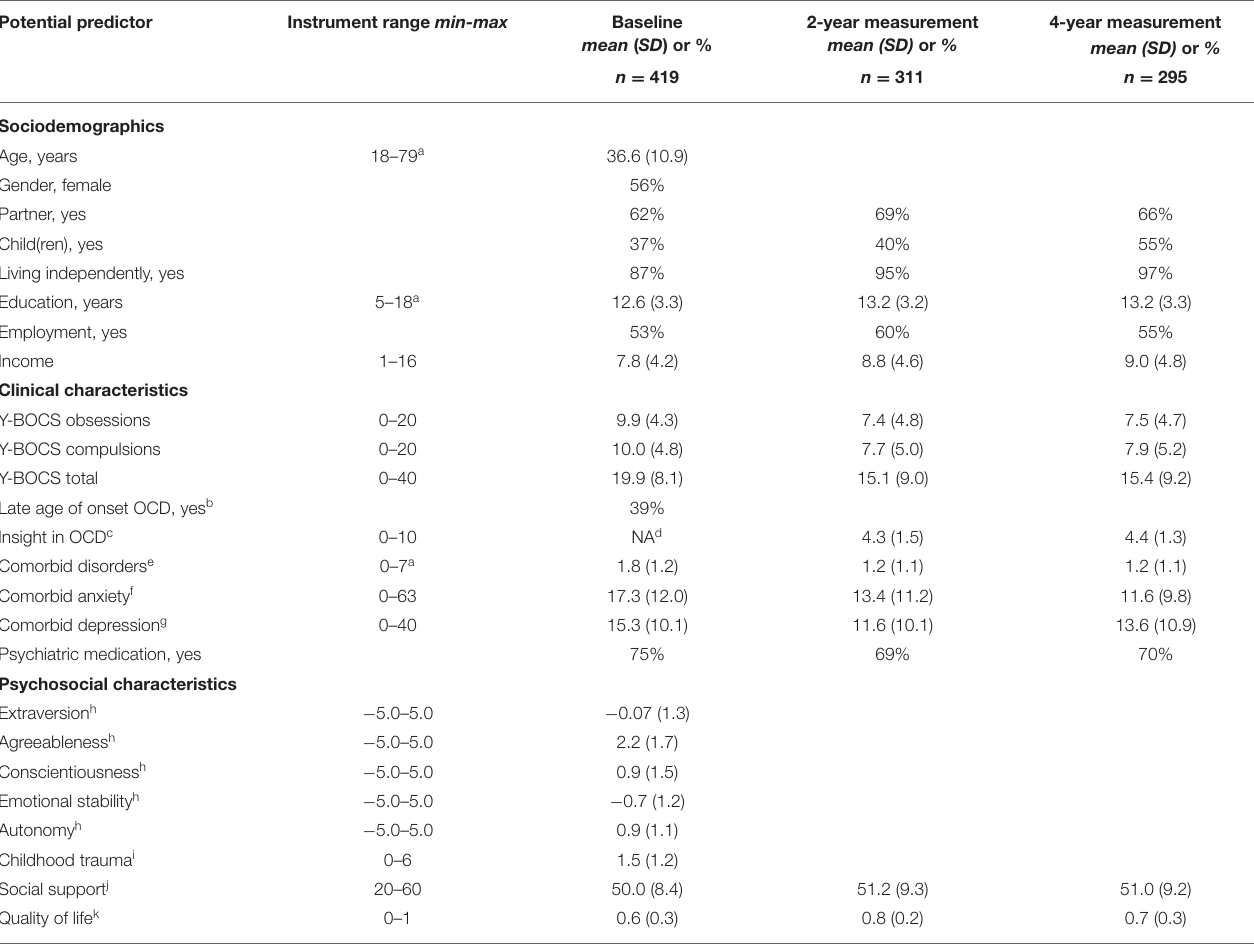
TABLE 1 | Descriptives of potential predictors of IT in patients with OCD. Potential